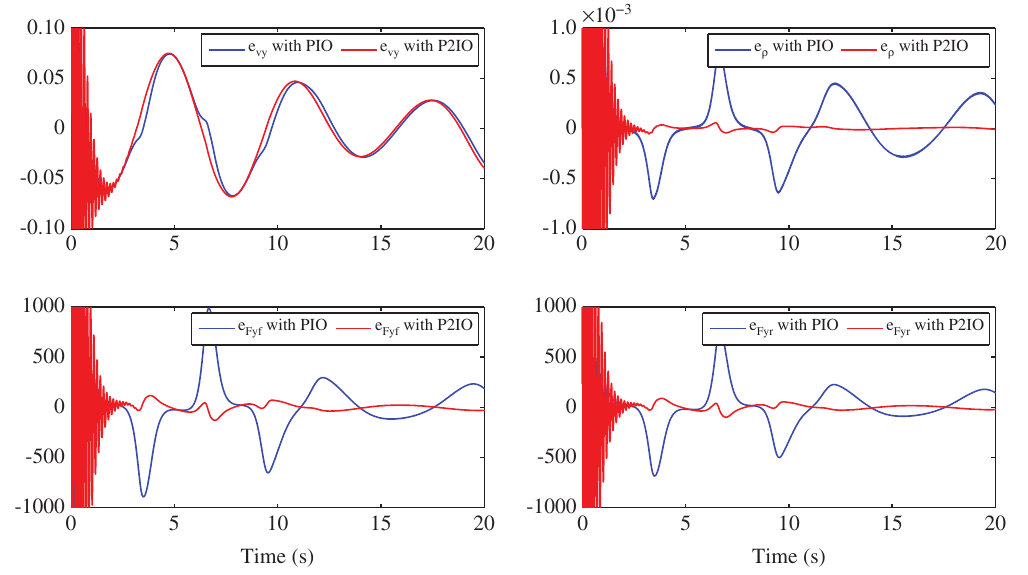
Figure 3. Comparison between State Estimation Error and Unknown Input Errors with Enhanced PI Observer and P2I Observer with Fixed ISS Gain to η = 0.1.